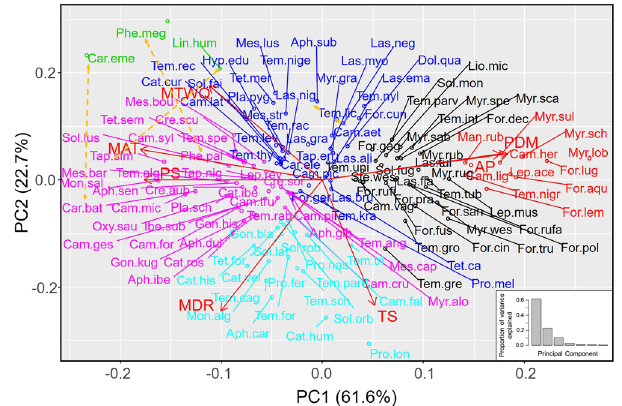
Figure 2. Principal components analysis (PCA) of ( a ) the 134 ant species; seven climatic variables were used to characterize the climatic niches. The existence of groups (indicated by different colors) was examined using K-means clustering analysis. Orange lines link each introduced species with its closest relative species in Europe in PCA space. See Fig. 1 for the climatic variable abbreviations. See Table S1 for the species name